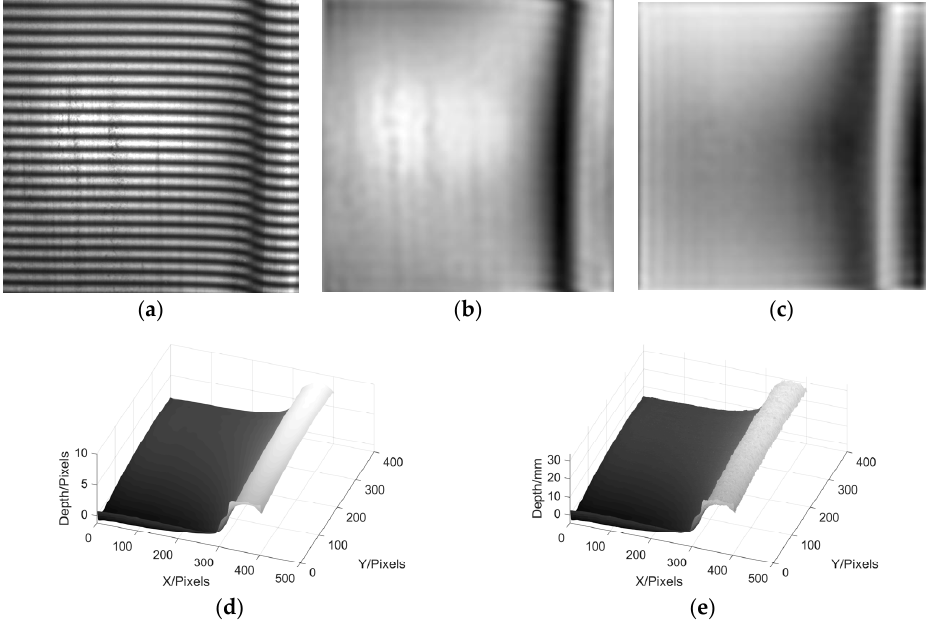
Figure 14. Experimental reconstruction results of wheel tread. ( a ) deformed fringe; ( b ) moire fringe pattern 1; ( c ) moire fringe pattern 2; ( d ) phase reconstruction; ( e ) height reconstruction.